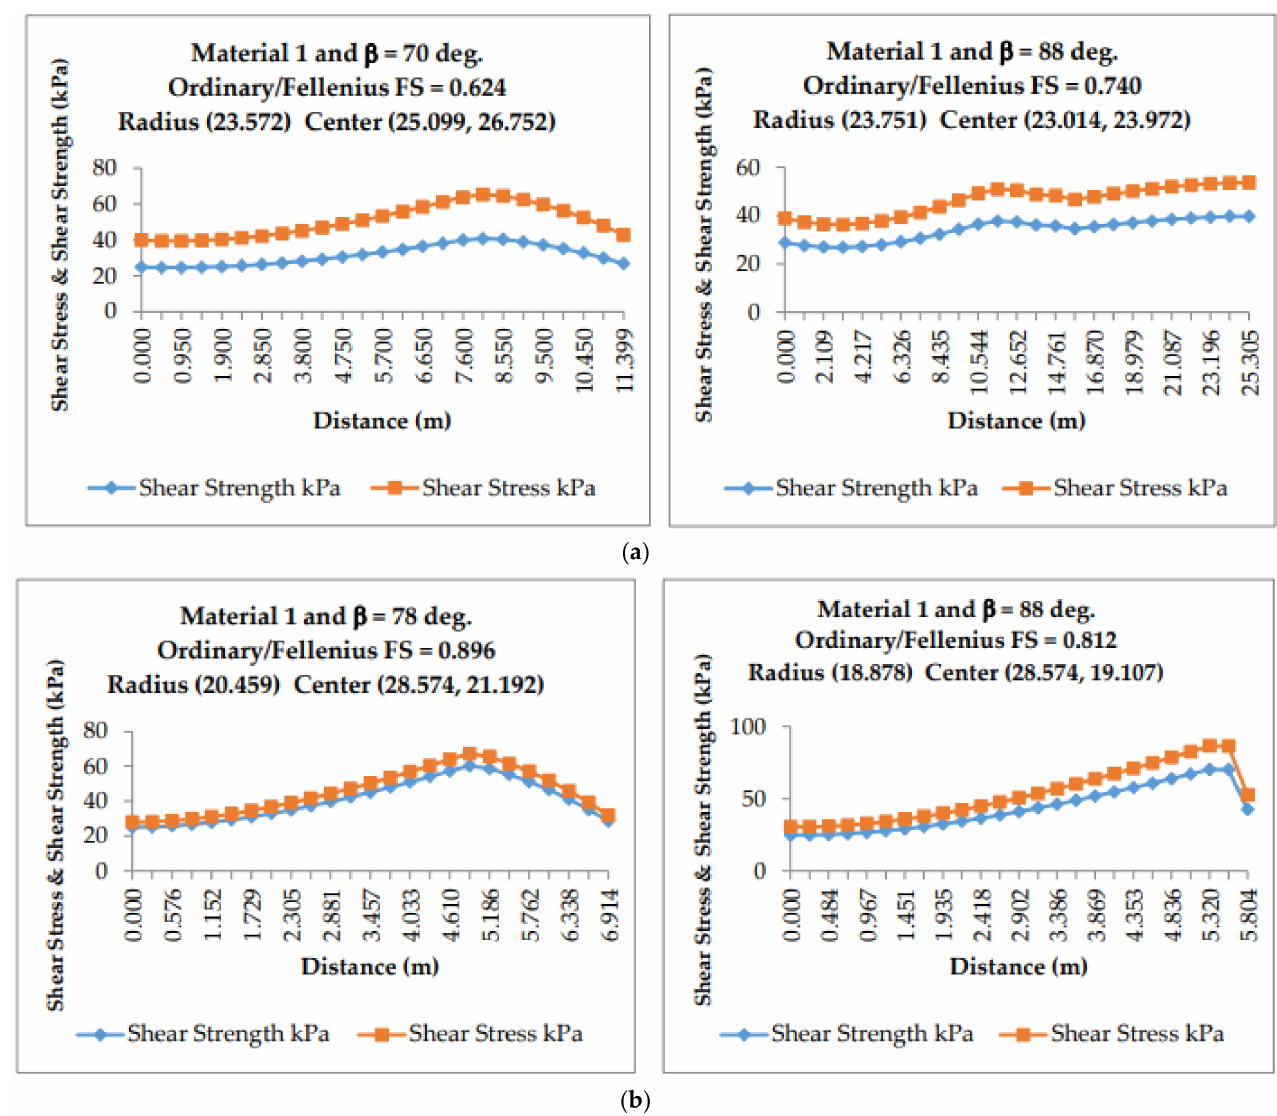
Figure 8. ( a ) . Shear strength and shear stress graphs in the case of Material 1 and 10 in a saturated case. ( b ). Shear strength and shear stress graphs in the case of Material 5 and 1 in an unsaturated